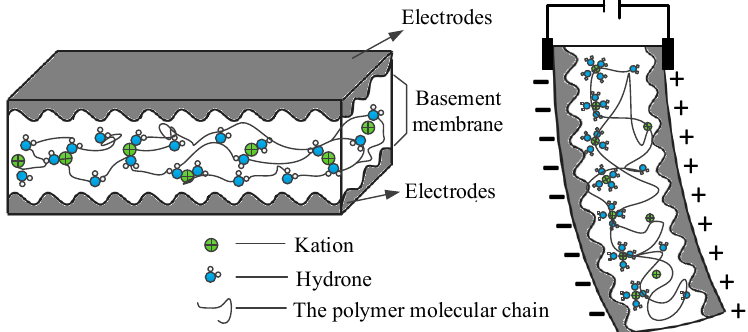
Figure 1. Structure and mechanism of electrically driven deformations of IPMC.